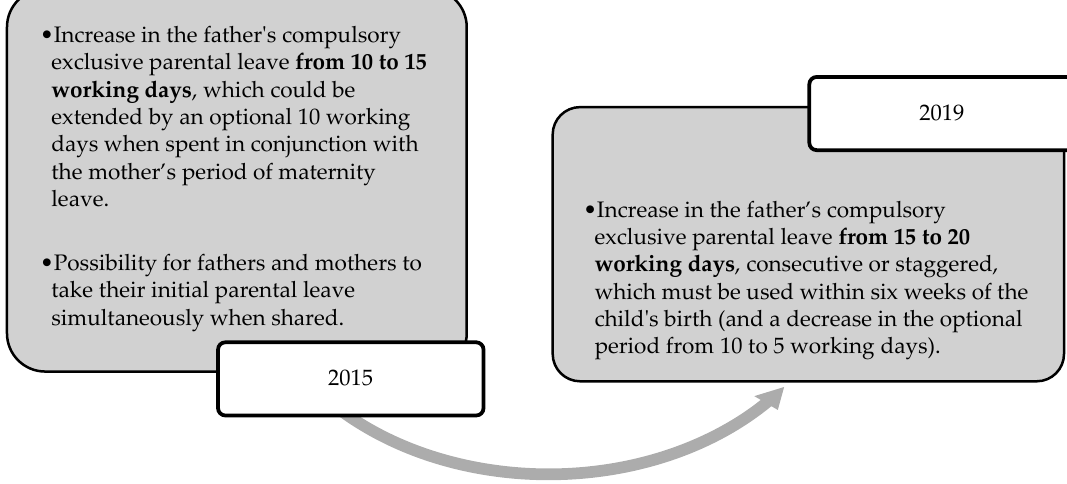
Figure 5. Most recent reinforcements of parental rights in Portuguese legislation (2015 and 2019) .